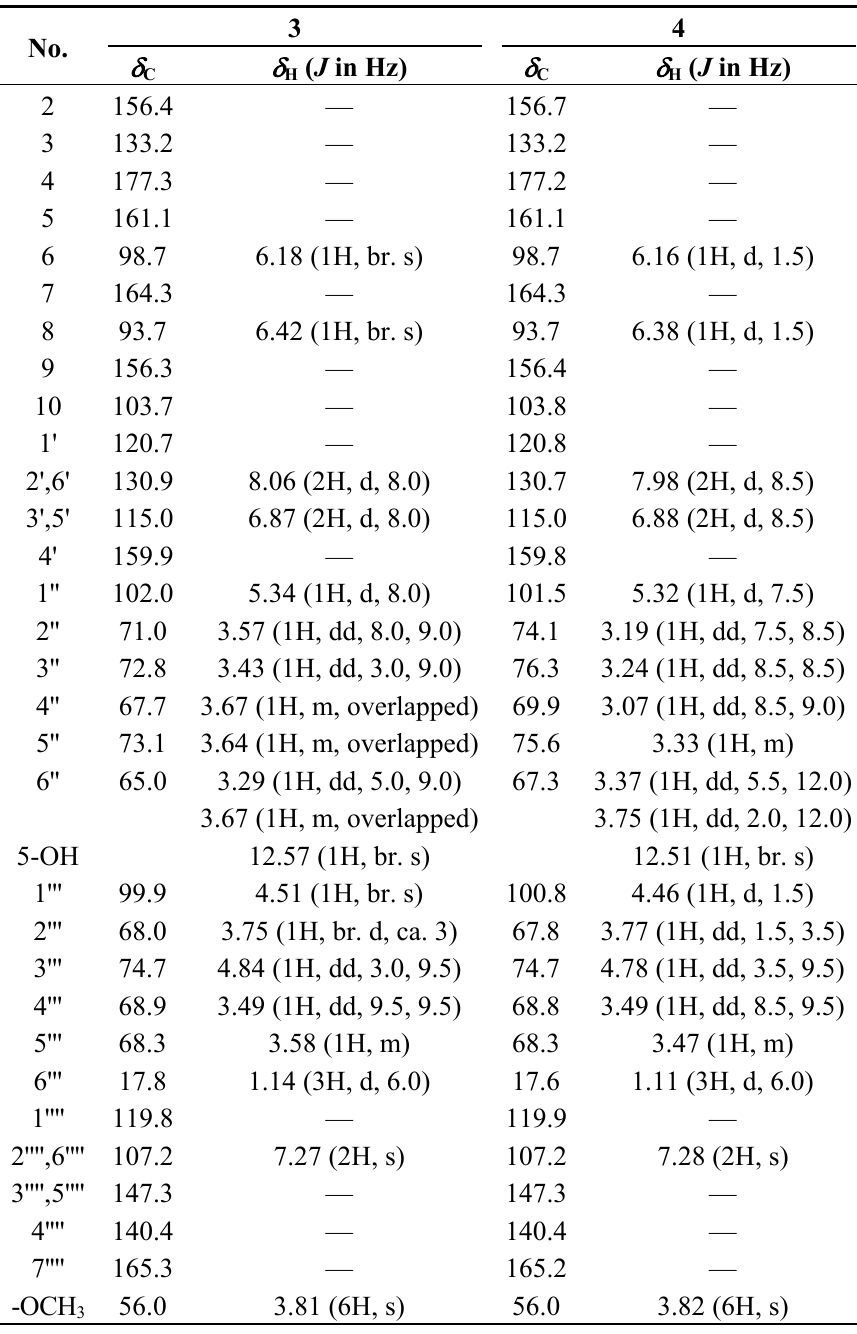
Table 2. 1 H and 13 C-NMR data for compounds 3 and 4 in DMSO- d 125 MHz for 13